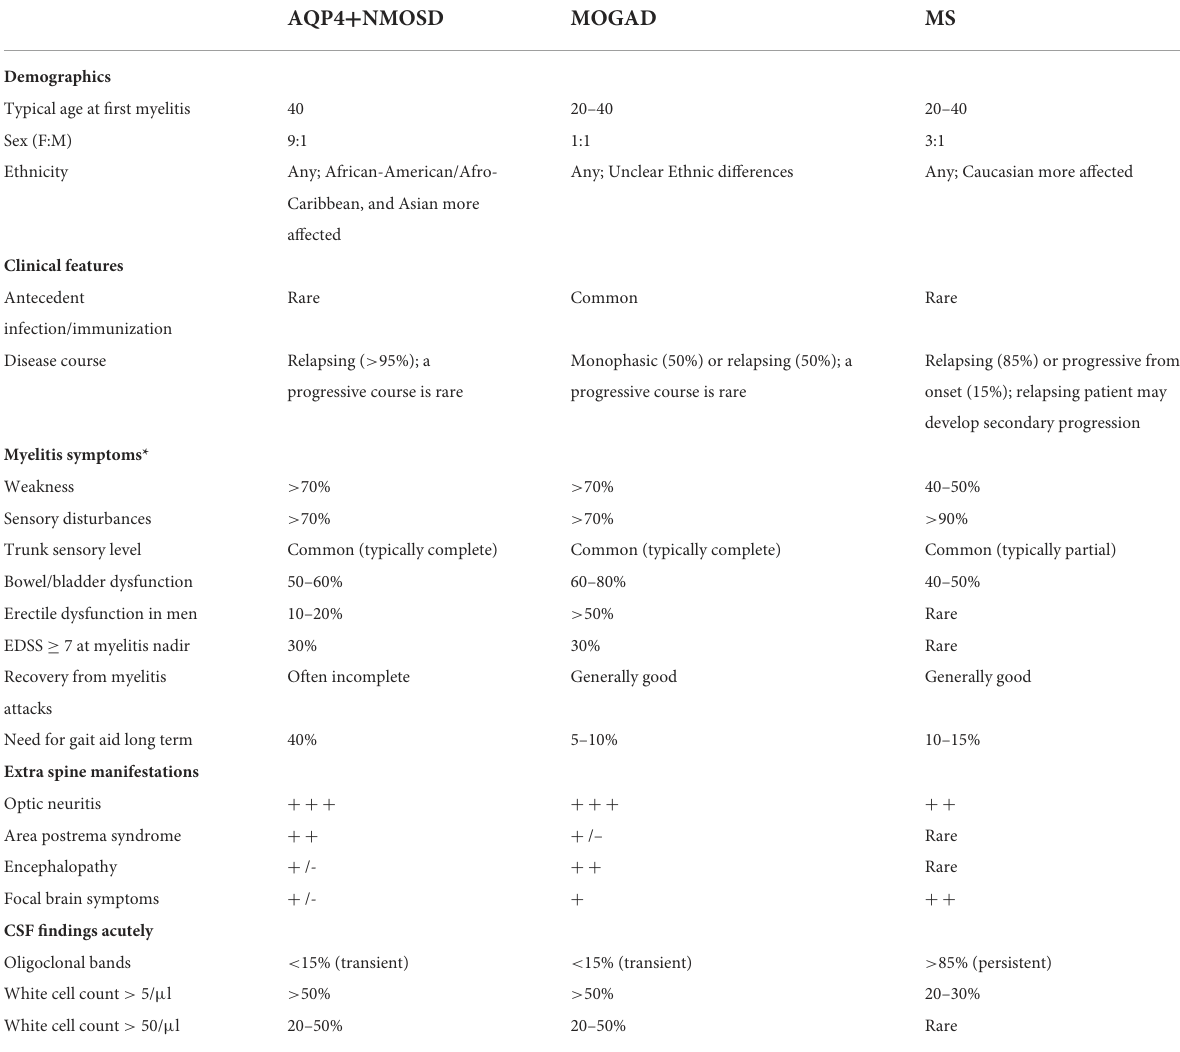
TABLE 1 Clinical and CSF findings in patients with AQP4-IgG-positive neuromyelitis optica spectrum disorders (AQP4 + NMOSD), MOG-IgG-associated disease (MOGAD), and multiple sclerosis